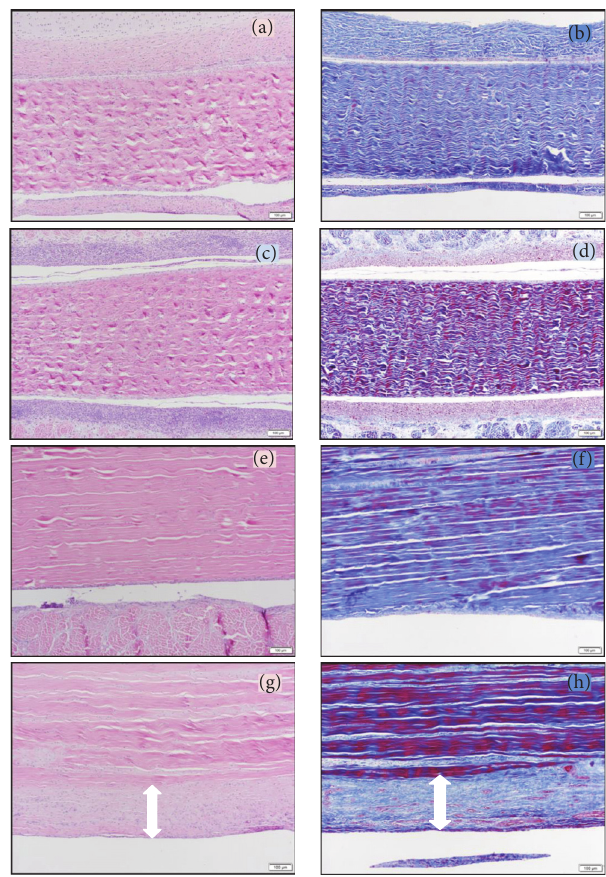
Figure 4: Histologic lesions in turkey poults after staining with Masson trichrome (MT) stain: (a) 4-week-old control turkey H&E; (b) 4- week-old control MT; (c) 4-week-old infected H&E; (d) 4-week-old infected MT; (e) 16-week-old control H&E; (f) 16-week-old control MT; (g) 16-week-old infected H&E; (h) 16-week-old infected MT. Inflammatory cells (lymphocytes) in subsynovium in (c) and (d). Collagen (indicative for fibrosis) deposition in the tendon (blue fibrils) in (g) and (h) (double headed white arrows).